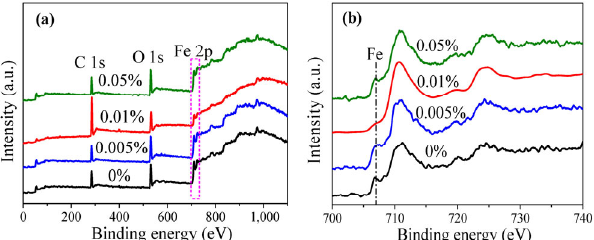
Fig. 11 XPS spectra of the rubbed surfaces lubricated by PAO6 containing or without TiL 4 /BP nanocomposites under the load of 20 N: (a) Survey and (b) Fe 2p.